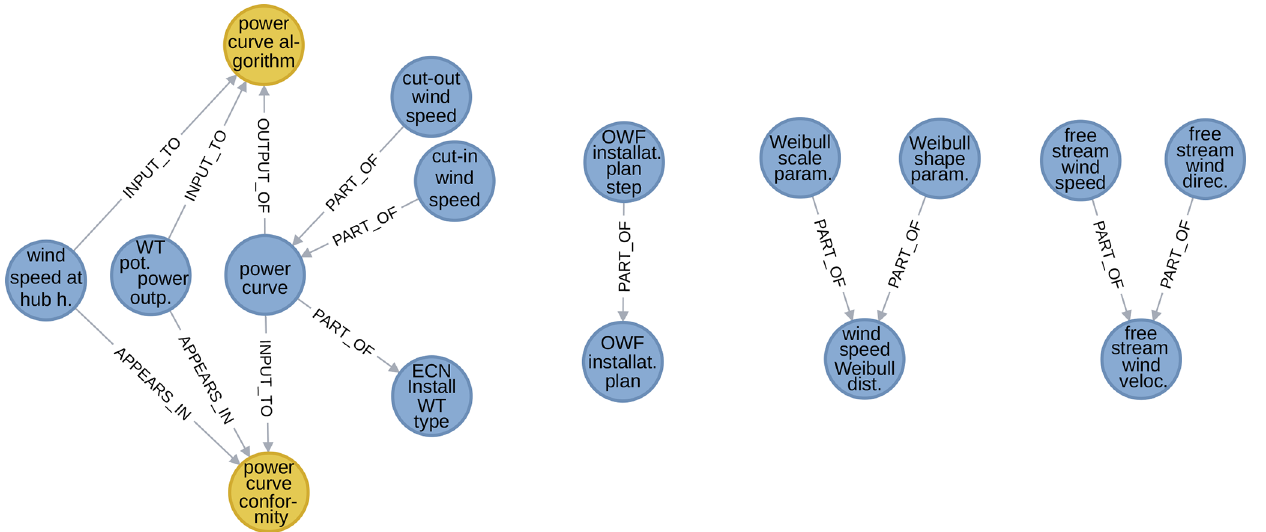
Figure 15. Examples of non-scalar variables and their surroundings in the graph (excerpt from